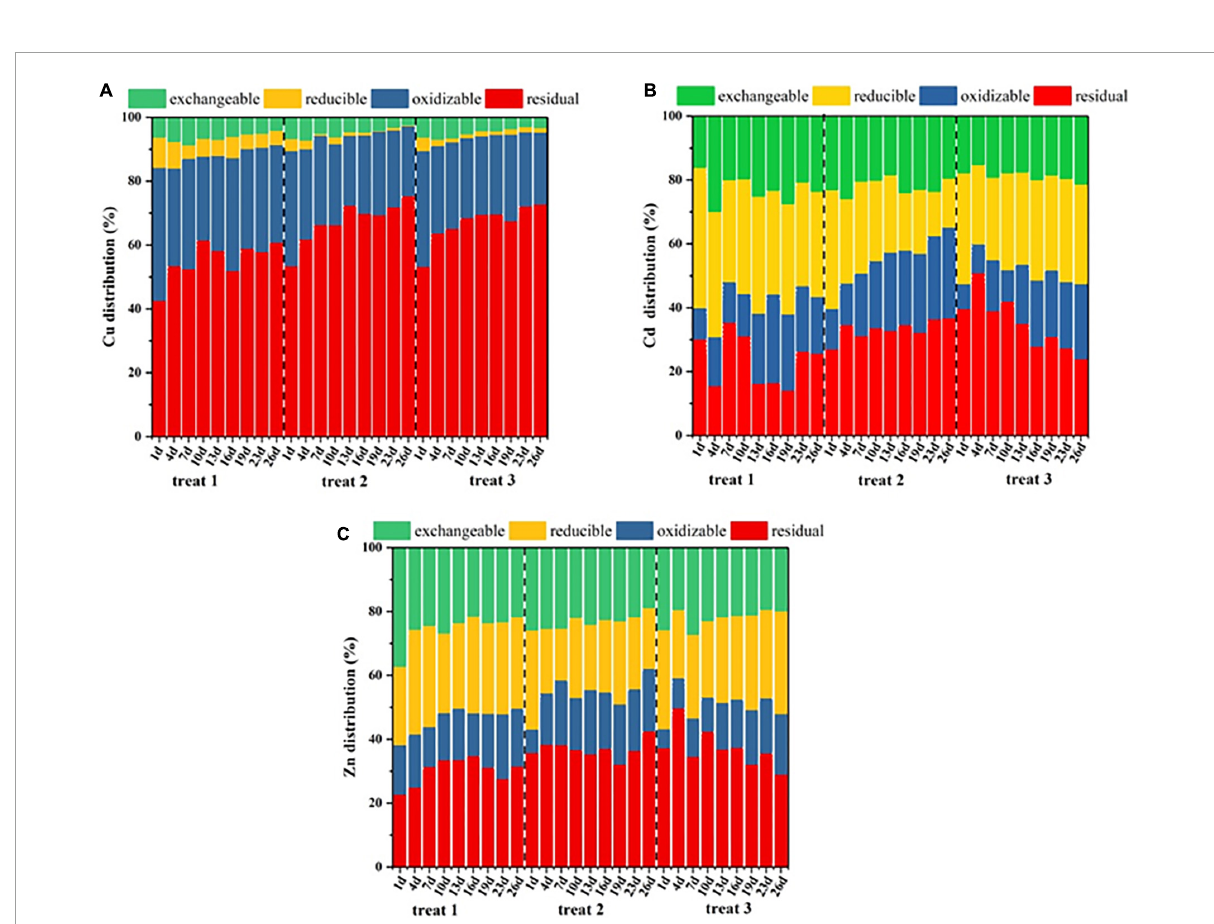
FIGURE2 Changes in (A) Cu distribution, (B) Cd distribution, and (C) Zn distribution during the composting process.